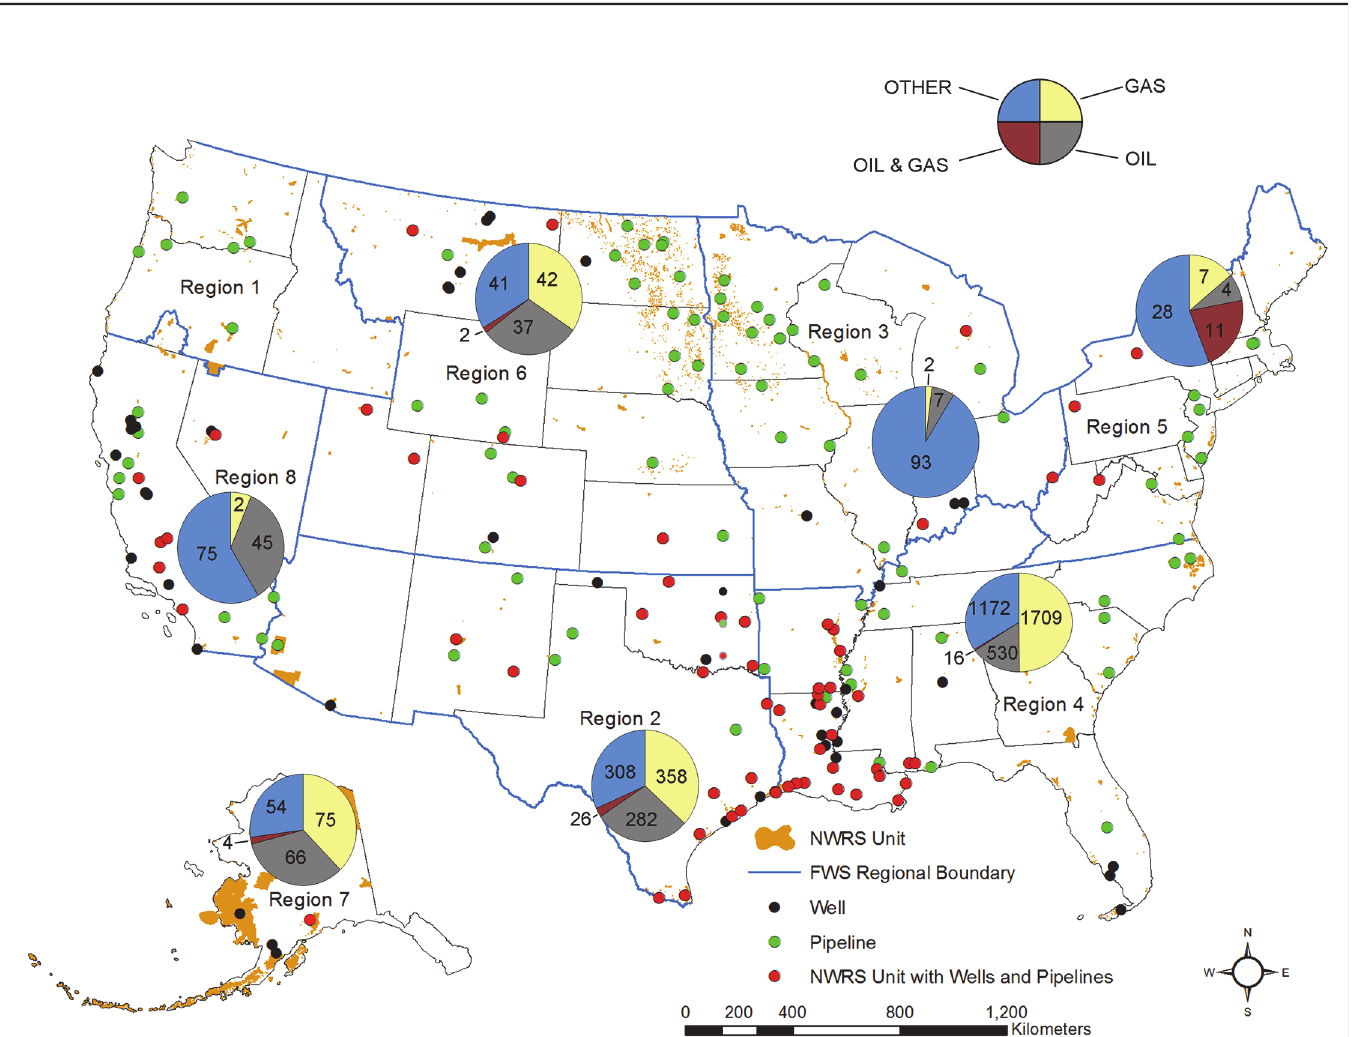
Fig 3. Number of Wells in NWRS Units by Region. Number and types of wells in National Wildlife Refuge System Units within U.S. Fish and Wildlife Service Regions. Pie charts show total number of wells by type for each region. Other wells include wells other than oil and gas, such as injection, saltwater disposal, enhanced oil recovery, dry, observation, stratigraphic, other, and production type data not available (N/A).